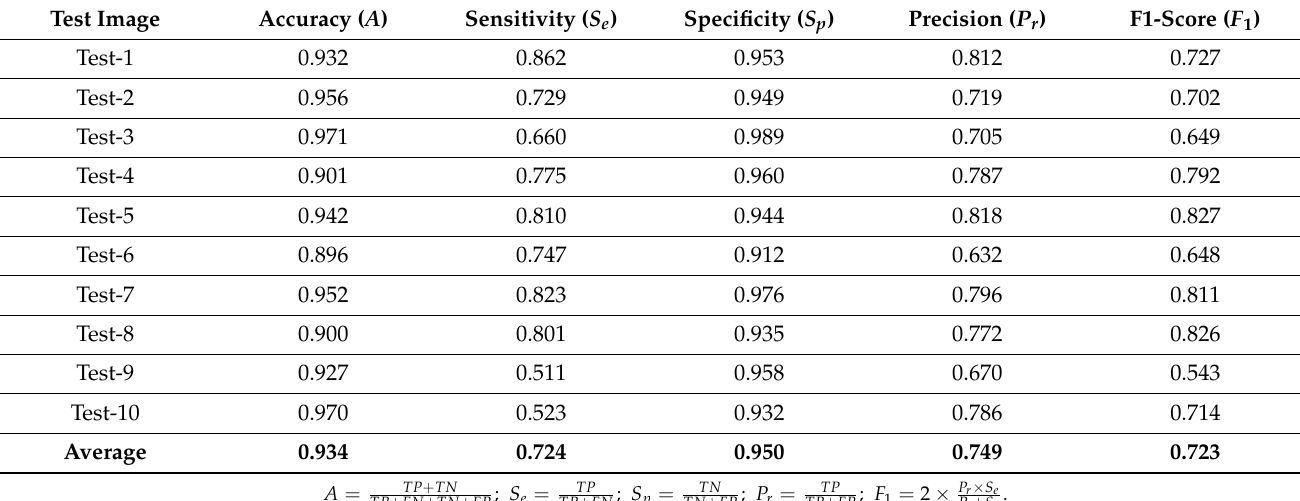
Table 5. Performance evaluation using 38 features for the 10 test image.